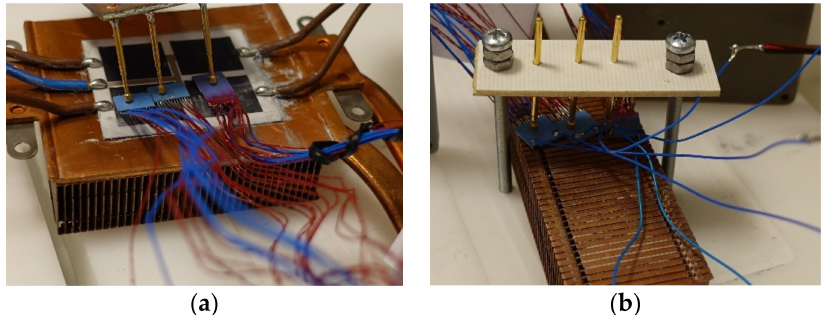
Figure 15. Sensor structures on the copper heat sink blocks: ( a ) the „hot” thermoelectric junctions on CPU_heat_sink; ( b ) the „cold” thermoelectric junctions on